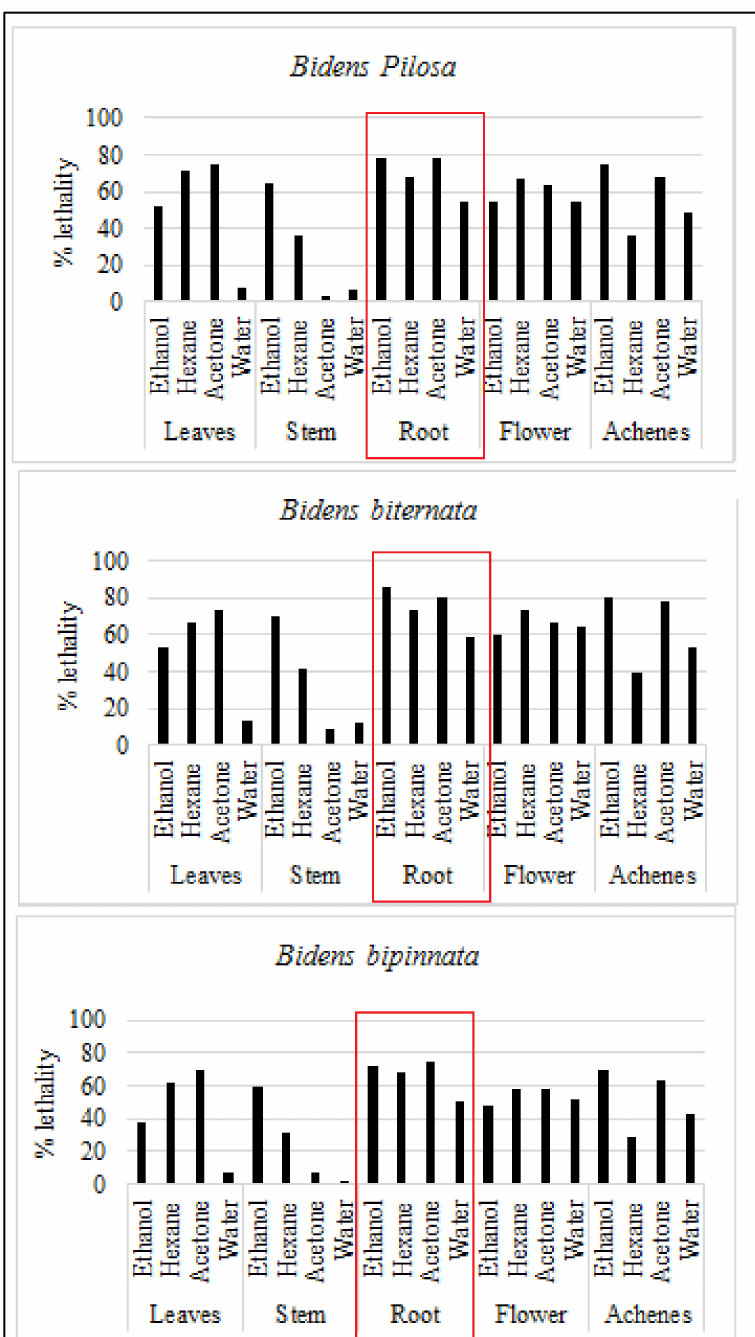
Figure 3. Mean percentage death (lethality) of selected plants against brine